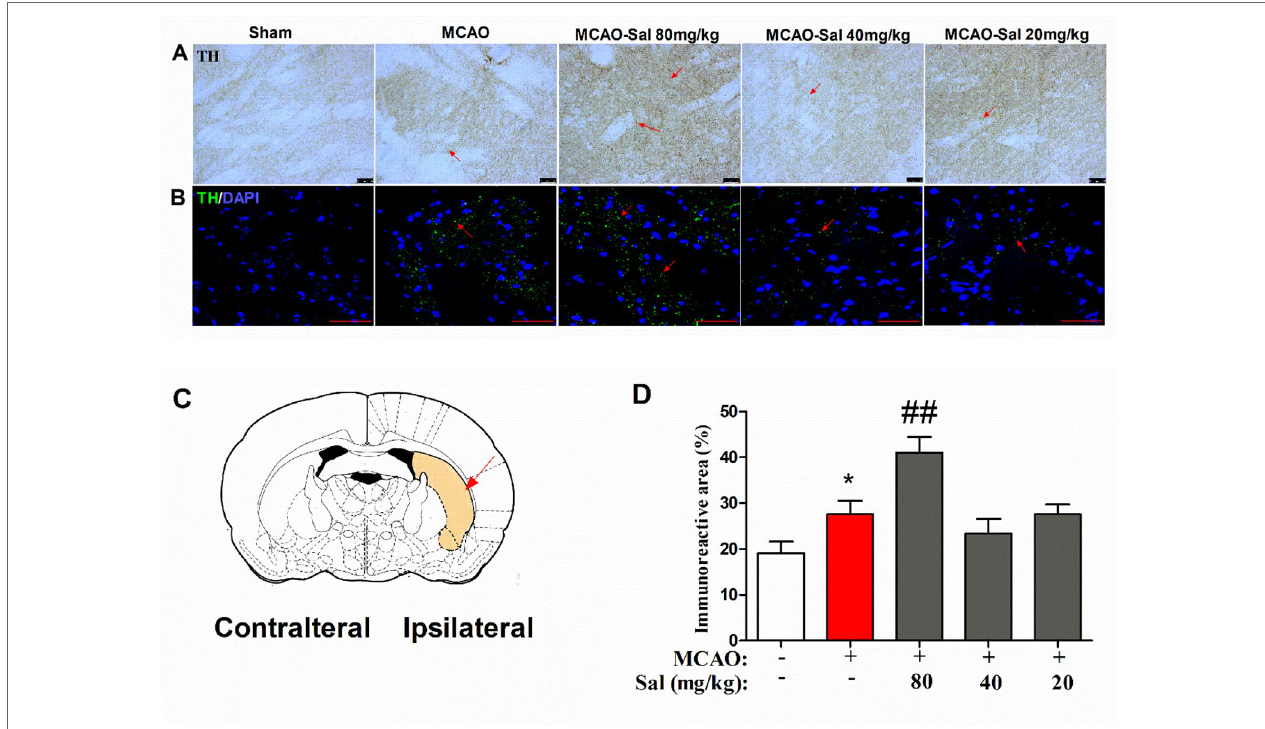
FIgURE 6 | Effects of salidroside on immunoreactivity of TH in the CPu after MCAO in rats. (a) TH immunohistochemical staining in the ipsilateral CPu. Arrows indicate TH-positive expression. Scale bar , 50 µm. (B) TH immunofluorescence staining in the ipsilateral CPu. Arrows indicate TH-positive expression. Scale bar , 50 µm. (C) Schematic diagram of the rat brain. Arrow indicates CPu. (D) Immunoreactivity area percent of TH-positive expression in the CPu after cerebral ischemia/ reperfusion in rats. Values are all represented as the mean ± SEM ( n = 5 rats per group). * p < 0.05 compared with the sham group; ## p < 0.01 compared to the MCAO group. CPu striatal caudate putamen, MCAO middle cerebral artery occlusion, tyrosine hydroxylase, SEM , standard error of the mean.